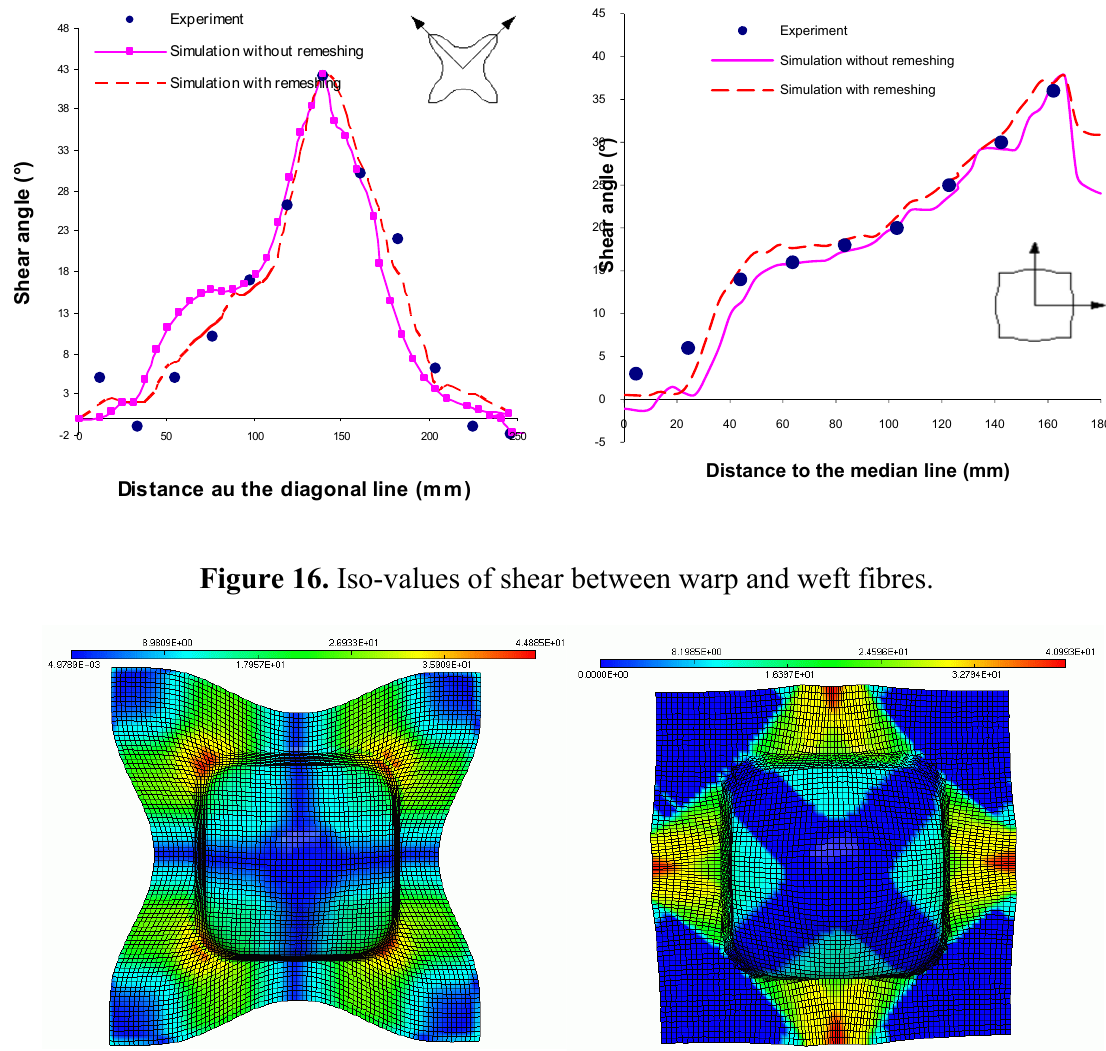
Figure 15. Shear variations along fabric lines with and without remeshing.